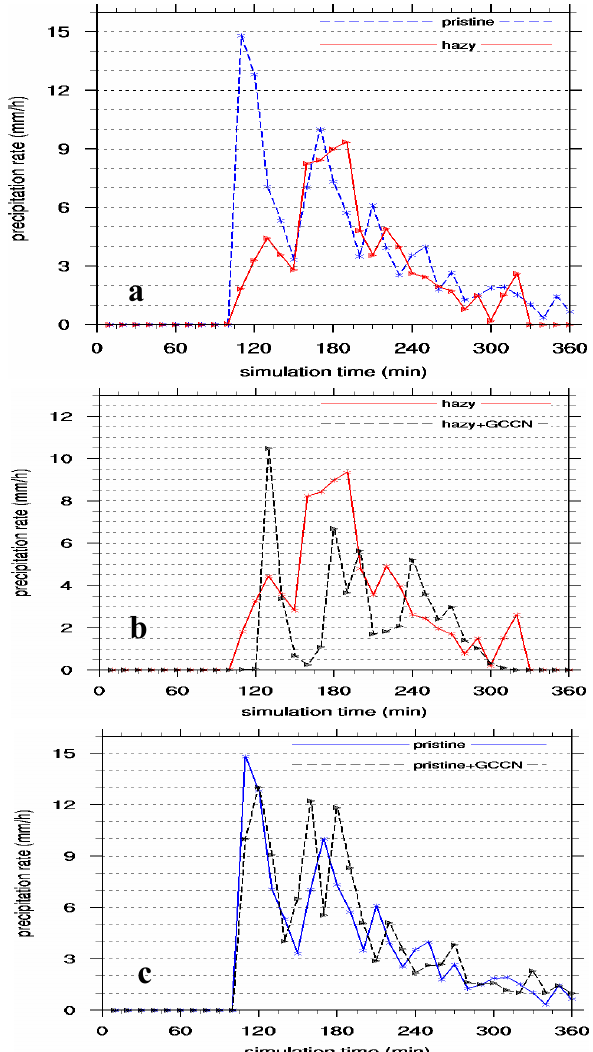
Fig. 4. Maximum precipitation rate (mmh − 1 ) for: (a) the “pristine” and “hazy” aerosol scenarios. (b) the “hazy” and “hazy+GCCN” aerosol scenarios. (c) the “pristine” and “pristine+GCCN” aerosol